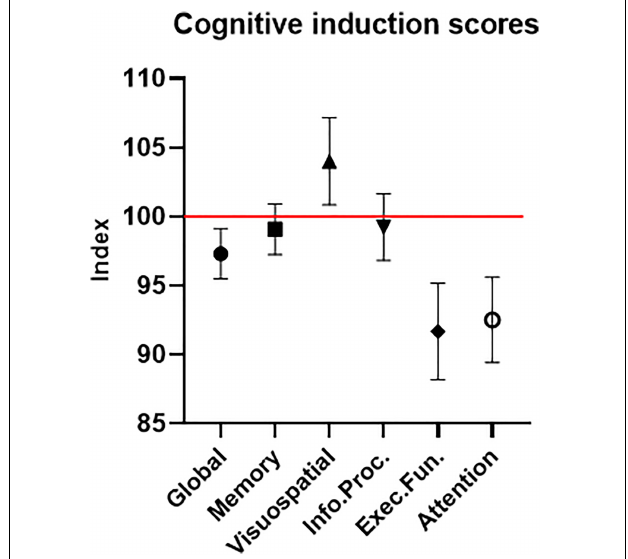
FIGURE 8 | Cognitive induction scores. The global score is comprised of the different cognitive domains’ sub-scores. The red line represents the healthy population’s normalized mean (100). Error bars stand for Standard Error of the Mean. As expected in an ADHD-diagnosed sample, the global cognitive score, as well as most sub-scores, were below the healthy population’s